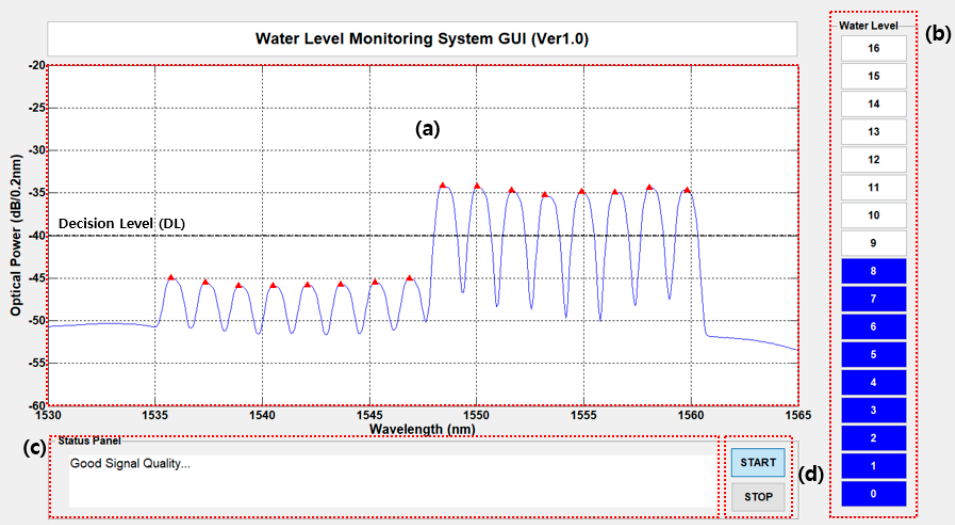
Figure 9. Configuration of the implemented HMI display module: ( a ) spectrum display window, ( b ) water level indicating bar, ( c ) status panel, ( d ) start/stop buttons.